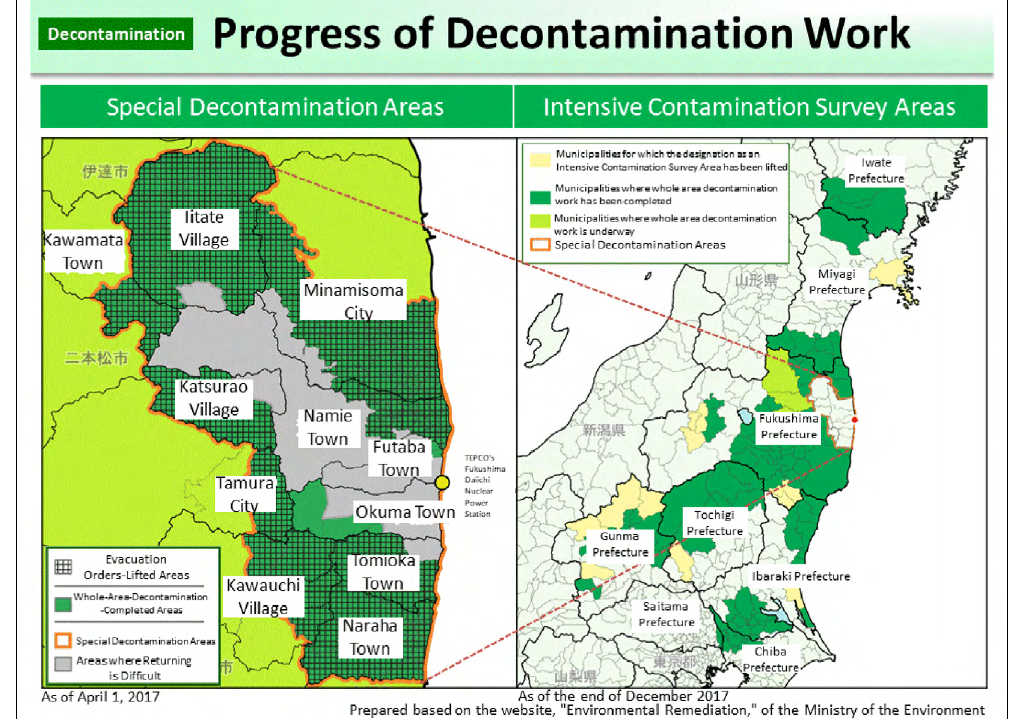
Figure 2 Map displaying the status of the Special Decontamination Areas and Intensive Contamination Survey Areas in 2017. Source: MOE 2018. Progress of decontamination. Available at https://www.env.go.jp/en/chemi/rhm/basic-info/1st/09-01-05.html (Last accessed 15 July